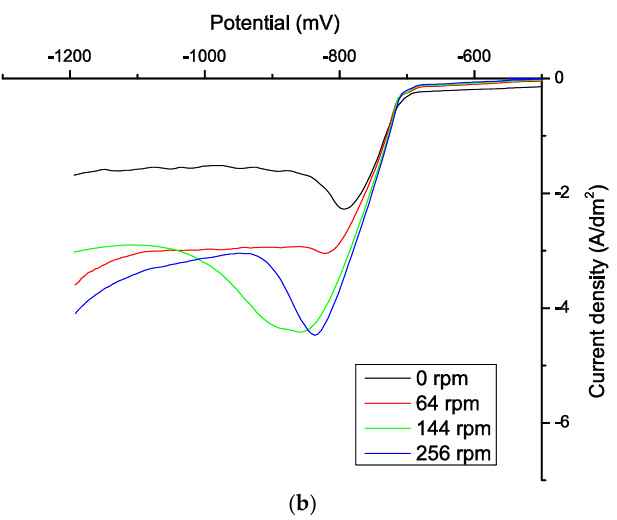
Figure 3. Polarization curves measured with the rotating disk electrode (RDE) in the chloride based electrolyte: ( a ) convection kept constant at 256 rpm and varying the ABN content. Cathodic current and H 2 evolution is suppressed with the increased additive concentration ( b ) with the optimum concentration of ABN 1.56 mg/L, varying the electrolyte convection. Introducing of the convection causes an increase in the limiting current densities. Cyclic voltammograms (CVs) of the electrodeposited tin from the chloride based electrolyte are Figure 4b. The forward cathodic scan exhibits a single current Sn deposition peak (~ − 0.7 V) followed